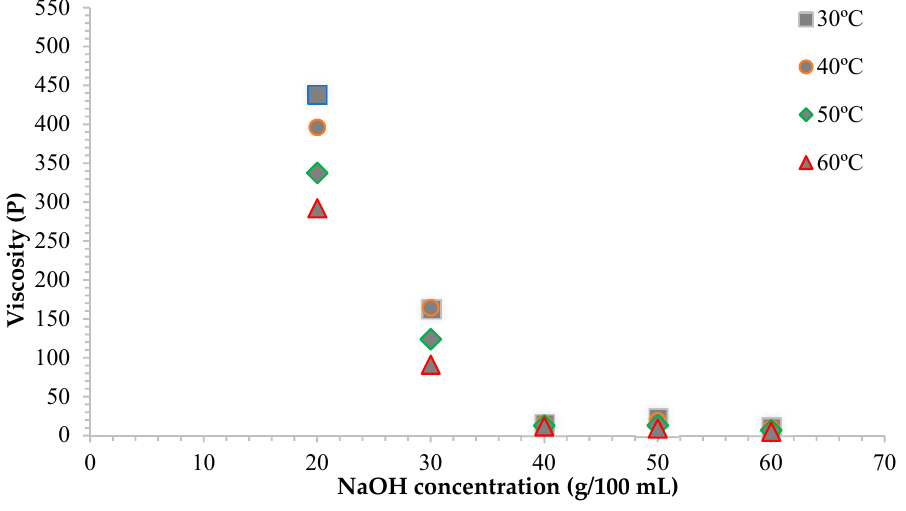
Figure 4. Effect of various NaOH concentrations on viscosity of CMC as .